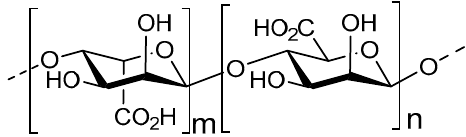
Figure 2. Structure of the main components of AOS; 1,4-linked β - D -mannuronic acid and 1,4-linked α - l -guluronic α - L -guluronic acid.